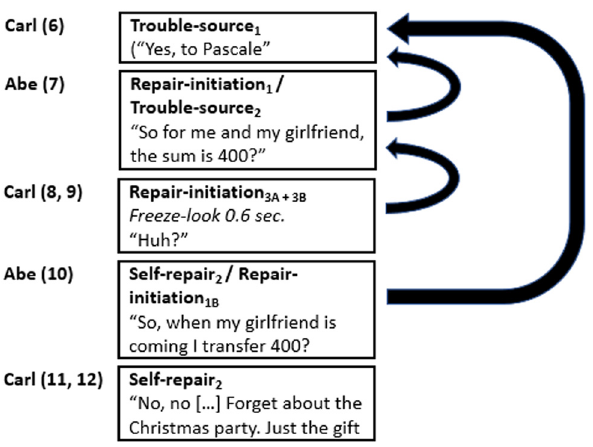
Figure 15: Multiple OIR sequences where a repair initiation becomes a new trouble